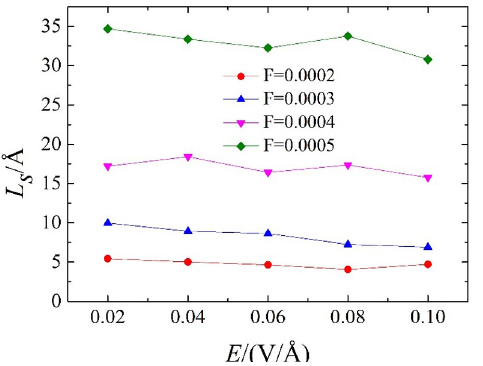
Fig 4. The slip length under the interaction of electric field strength and driving